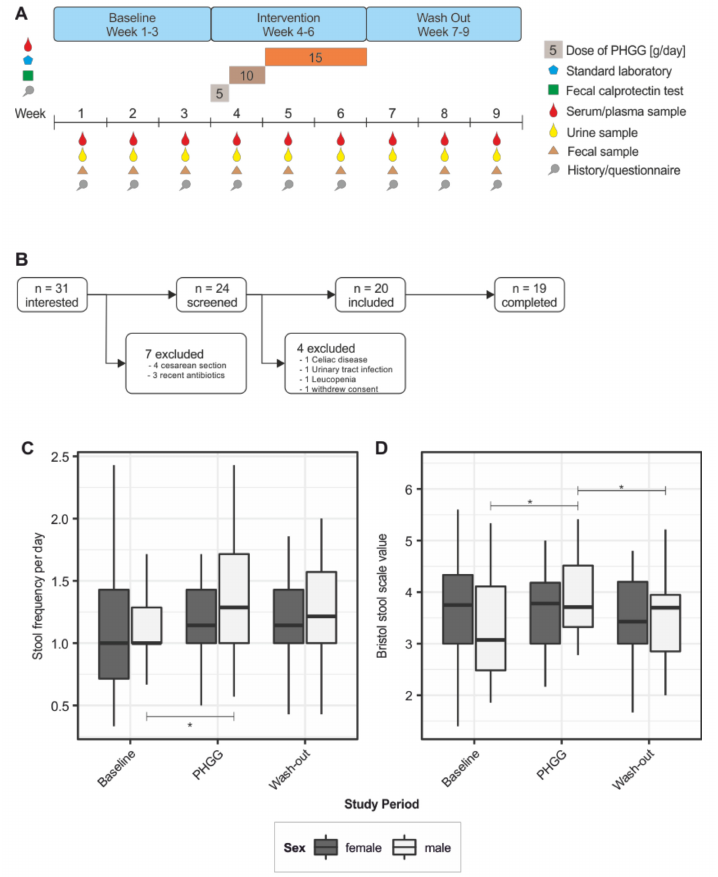
Figure 1. Study design and clinical e ff ects of PHGG supplementation. ( A ) Outline of the design and sampling procedure of the PAGODA study; ( B ) screening process and number of participants included in this study; ( C ) e ff ect of PHGG supplementation on stool frequency; ( D ) e ff ect of PHGG supplementation on stool consistency according to the Bristol stool scale value. PHGG = partially hydrolyzed guar gum; * p < 0.05; linear mixed